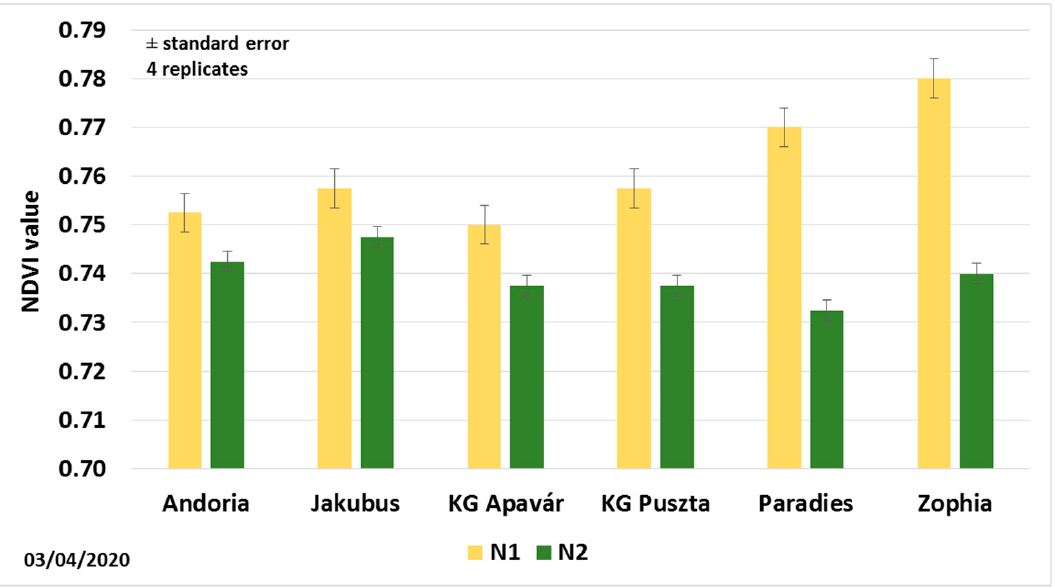
Figure 9. NDVI values of winter barley cultivars in different N fertilization doses (Debrecen, 2020) Standard error of means, 4 replicates. At BBCH 27 − 29 plots under higher N fertilization had lower NDVI values. The difference was statistically significant ( p < 0.05). N1: N 90 P 45 K 50 ; N2: N 150 P 45 K 50 kg ha − 1. Table 5. NDVI values of winter barley cultivars (2020, Debrecen).